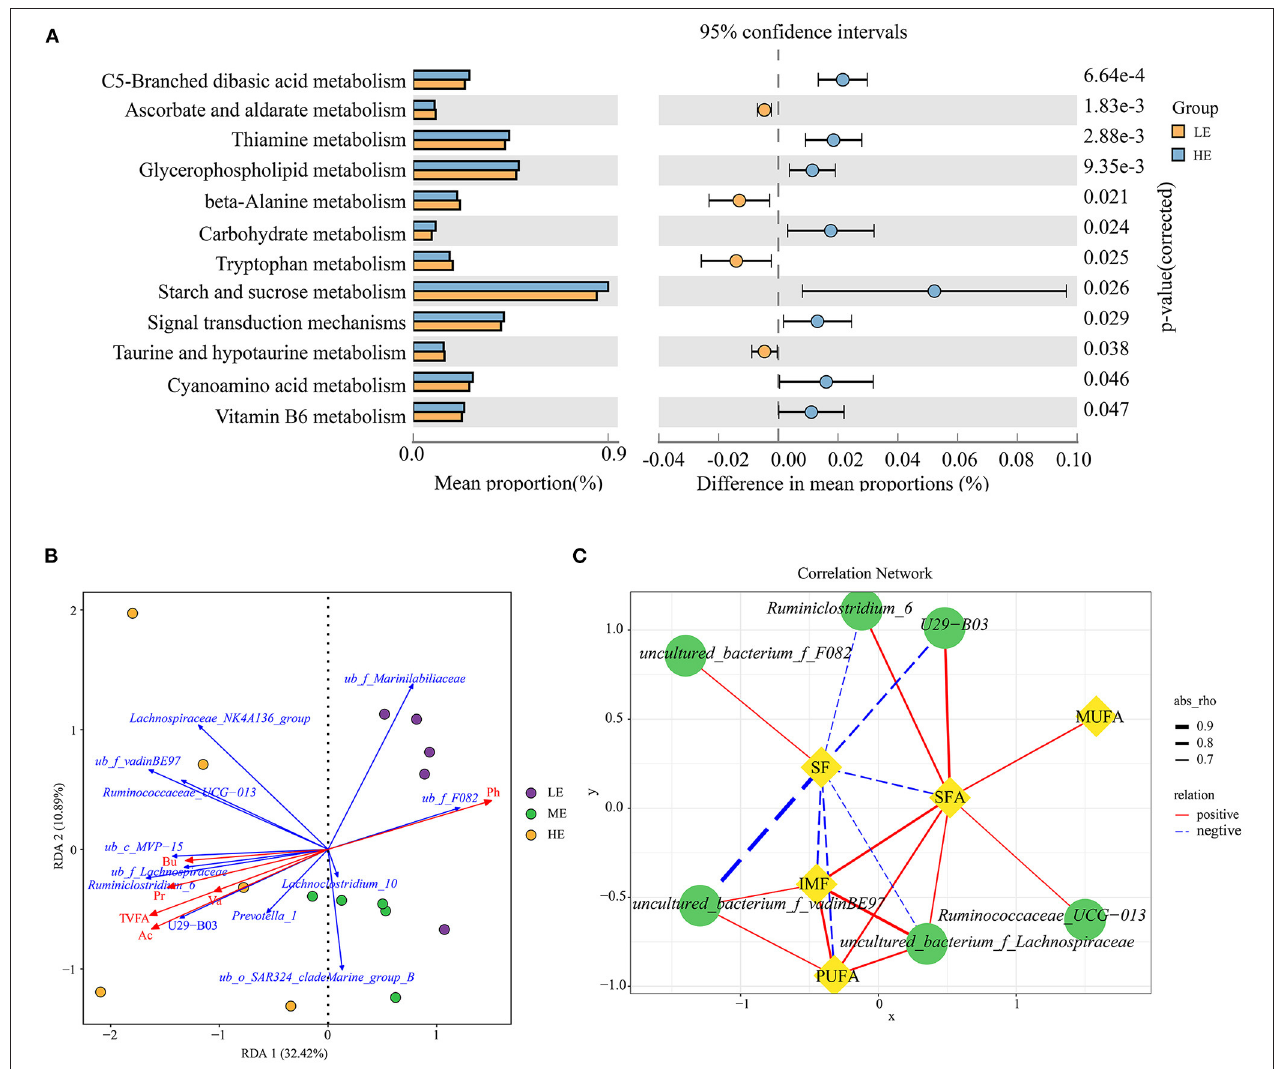
FIGURE 2 | Predicted function analysis of ruminal bacteria and correlation analysis between the phenotypic values and ruminal main taxa. (A) Pathways were predicted by PICRUSt2. The significant microbial metabolic pathways between the HE and LE groups ( P -value < 0.05) are shown. (B) Redundancy analysis (RDA) of the sequencing data of the 16S rRNA gene showing relationships between the differential bacteria and environmental factors (TVFA, acetate, propionate, butyrate, valerate, and pH). TVFA, Total VFA; Ac, Acetate; Pr, Propionate; Bu, Butyrate; Va, valerate; ub, uncultured_bacterium. (C) Spearman’s correlation network showing relationships between the relative abundance of differential bacteria at the genus level and the meat quality indices. Only the strong correlations (| r | > 0.60 and P -value < 0.05) were showed in the correlation